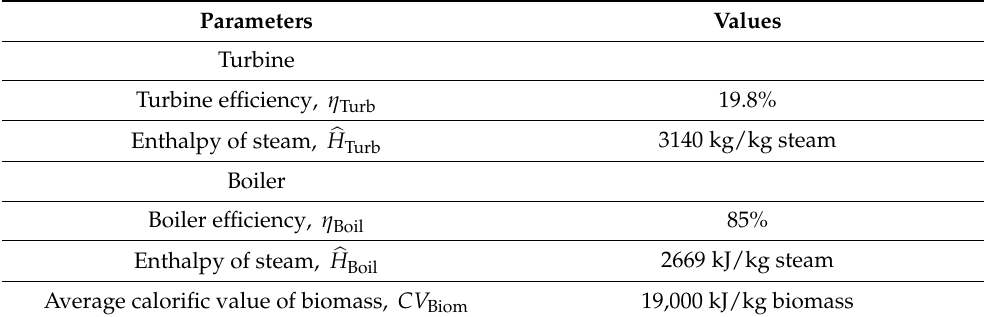
Table 1. Important parameters for power generation.